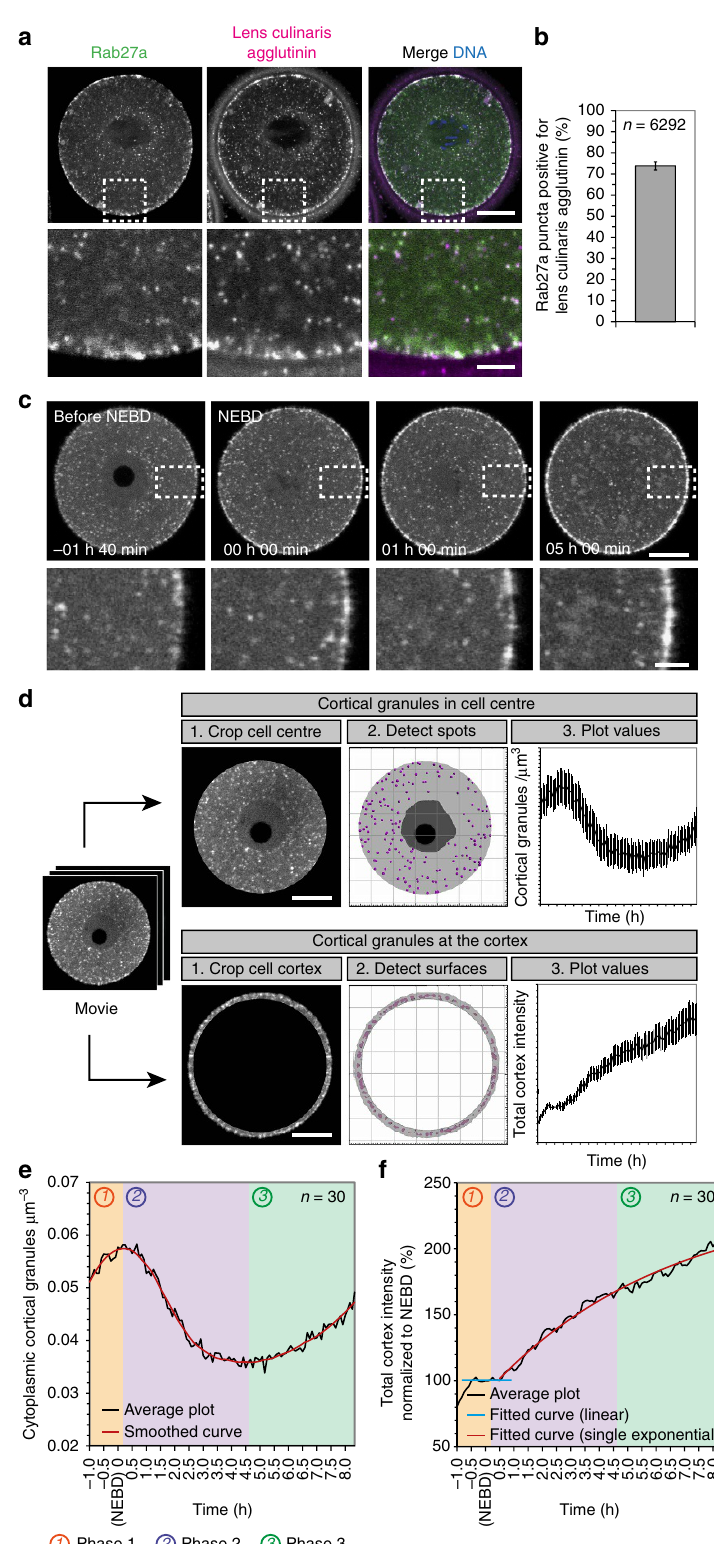
Figure 1 | Rab27a is a marker for cortical granules. ( a ) Oocyte expressing GFP-Rab27a, fixed and stained with lens culinaris agglutinin, a cortical granule marker. Scale bar, 20 m m. ( b ) Quantification of the colocalization of Rab27a puncta with lens culinaris agglutinin puncta (mean ± s.d. from three experiments). Total number of Rab27a puncta quantified are indicated. ( c ) Cortical granules visualized with GFP-Rab27a translocate from the centre of oocytes to the cortex, where they become enriched. Scale bars, 20 m m (overview) and 5 m m (enlarged). ( d ) Schematic diagram of the quantification methods for cortical granule translocation and enrichment at the cortex. Scale bars, 20 m m. ( e ) Cortical granule dynamics in the oocyte centre during meiotic maturation. Three separate phases can be identified in the cell centre, which are colour-coded in all subsequent graphs. The start and end of each phase was determined by calculating the derivative of the data. ( f ) Cortical granule enrichment at the oocyte cortex during meiotic maturation. The three separate phases identified in the cell centre are